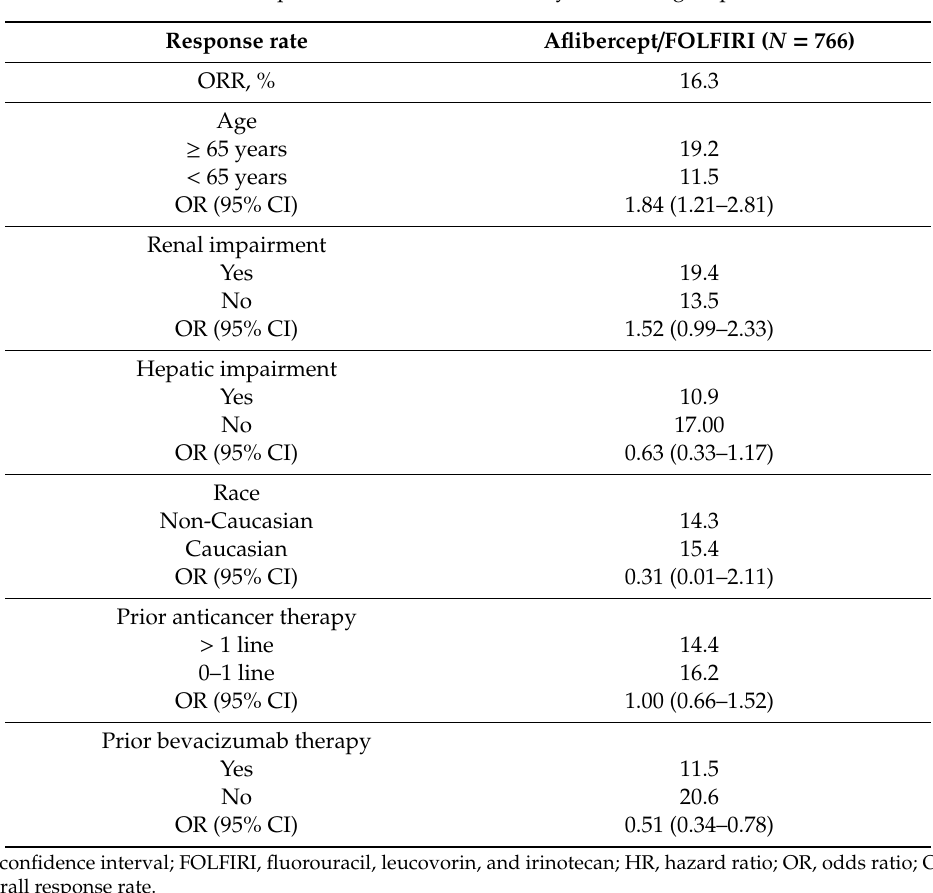
Table 5. Overall response rate multivariate analyses for subgroups of interest.